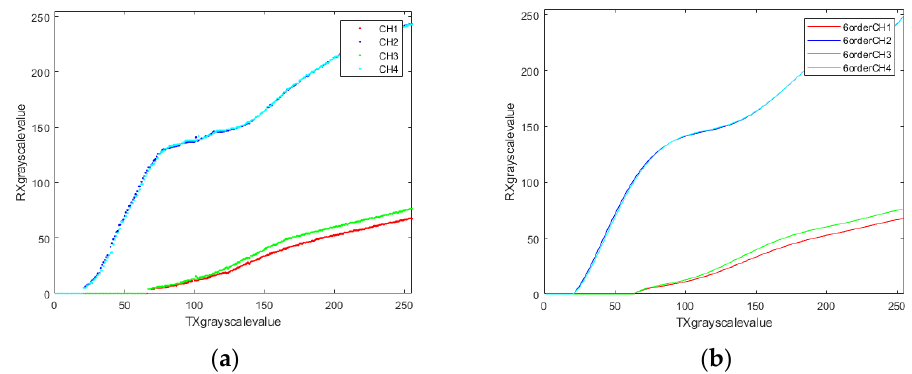
Figure 8. The relationships between transmitted and received signals are illustrated for four channels. ( a ) The pixel-wise detected models; ( b ) the high-order regression models. With the equal bit allocation, the transmission bit number in each shot is two in each channel. Accordingly, each channel is incorporated with 4-PAM. Indeed, the proposed VLC system applies grayscale values to transmitted and received signals and is still in the same range [0, 255]. Therefore, the minimum transmitted signal is 0, and the maximum is 255. Regarding the gain of each channel, the received signals, in terms of averaged gray- scale values, are shown in Table 2. The minimum mean-squared error (MMSE) equalizer is applied to evaluate the proposed system with AWGN, as noted in (3), similar to ambient shot light noise and thermal noise. In a real case with 30dB SNR (signal-to-noise ratio)